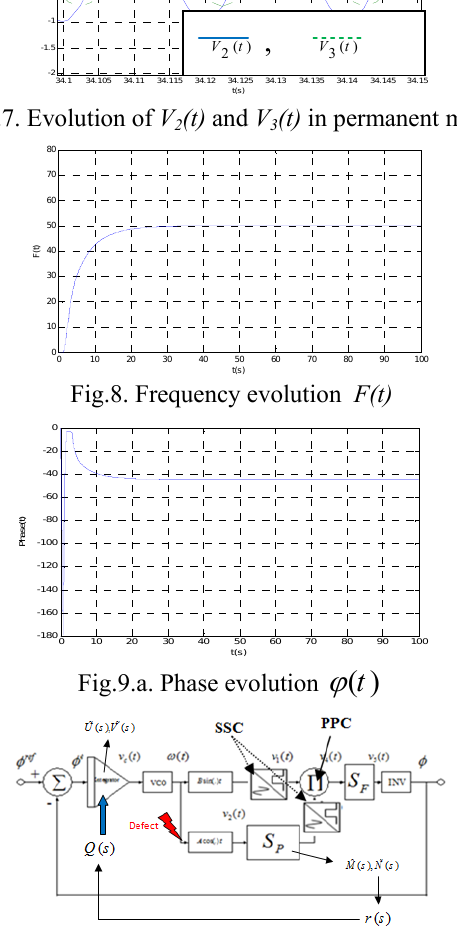
Fig.9.b. Application of GIMC structure on the module